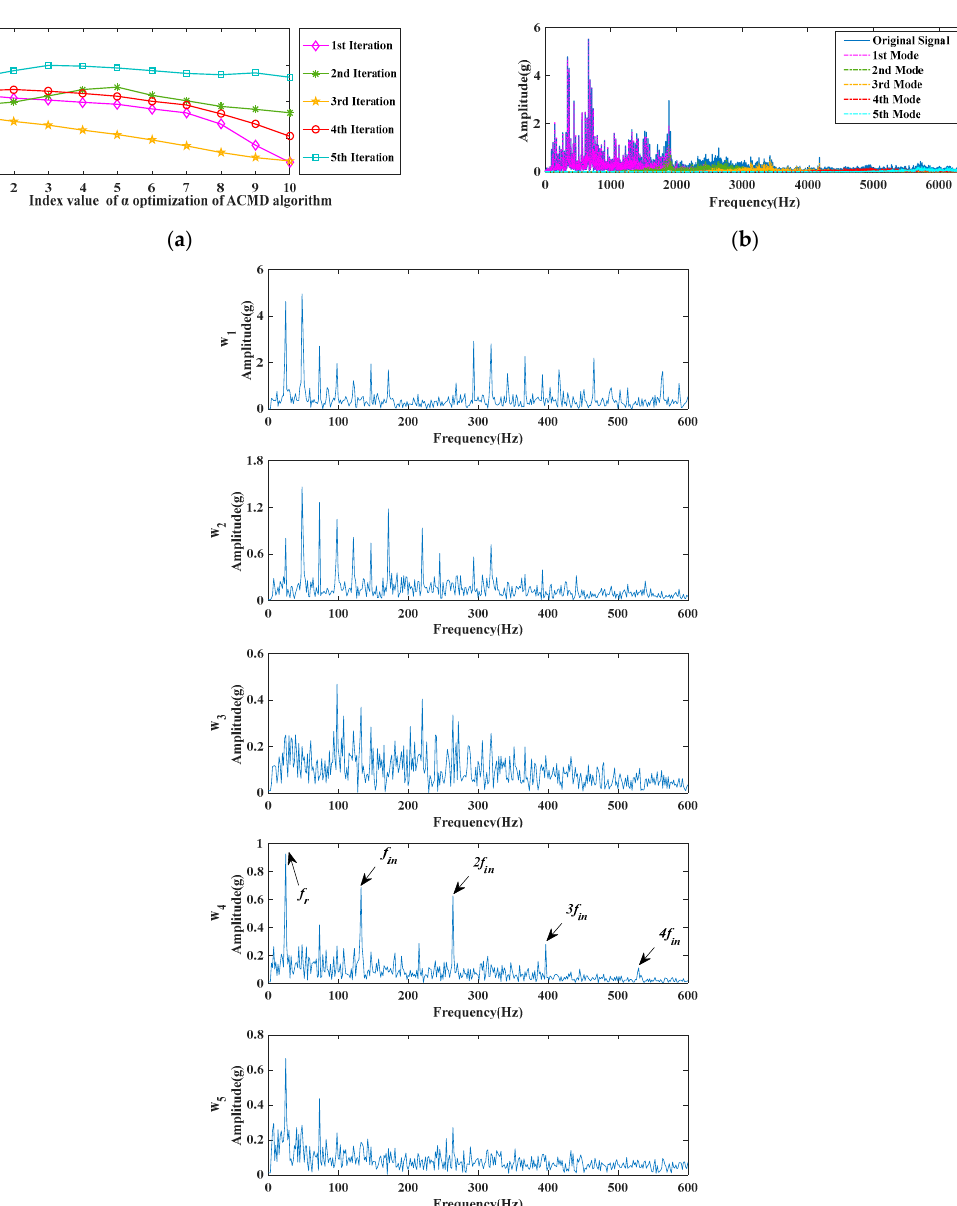
Figure 15. The envelope interpolation method process of experimental inner race failure signal: ( a ) 1st time execution; ( b ) 2nd time execution; ( c ) 3rd time execution; ( d ) 4th time execution.